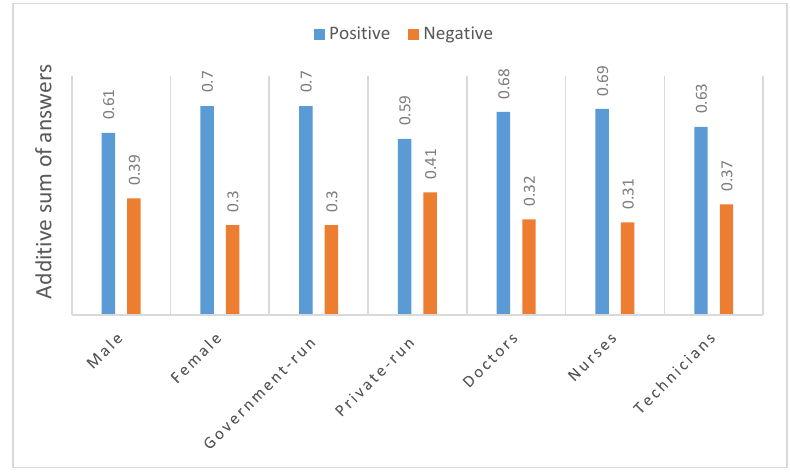
Fig. 4: Module 3 additive sums of positive answers (blue) and negative answers (orange)